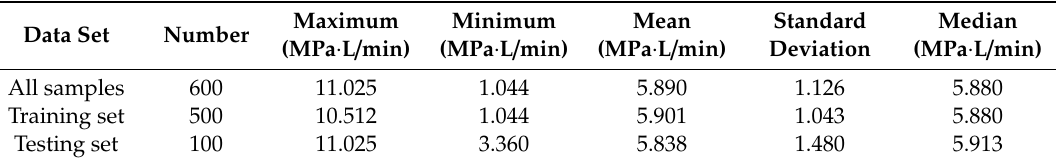
Table 1. Statistical descriptions of the grouting power series.